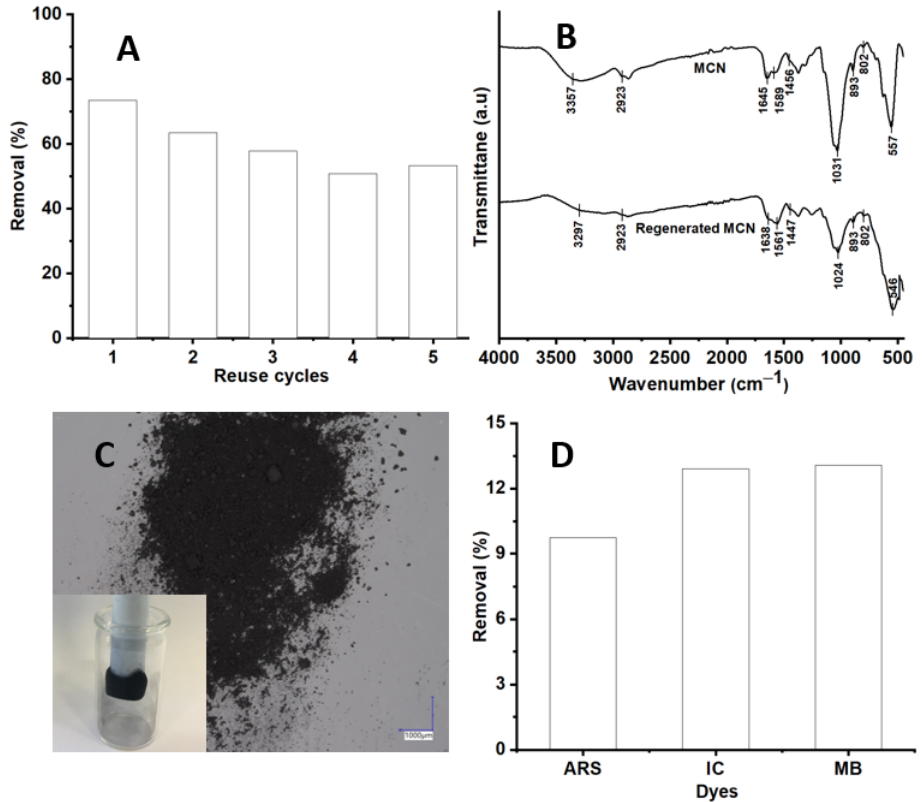
Figure 6. ( A ) Reuse cycle analysis of MCN for the removal of ARS dye; ( B ) ATR-FTIR spectra of MCN and regenerated MCN; ( C ) Optical image of produced N-doped magnetic carbon and magnetic properties of N-doped magnetic carbon; ( D ) Removal of ARS, IC, and MB dyes by the N-doped magnetic carbon (experimental conditions: solution pH, 6.8; dye concentration, 10 mg/L; N-doped carbon dosage, 25 mg; contact time, 60 min).